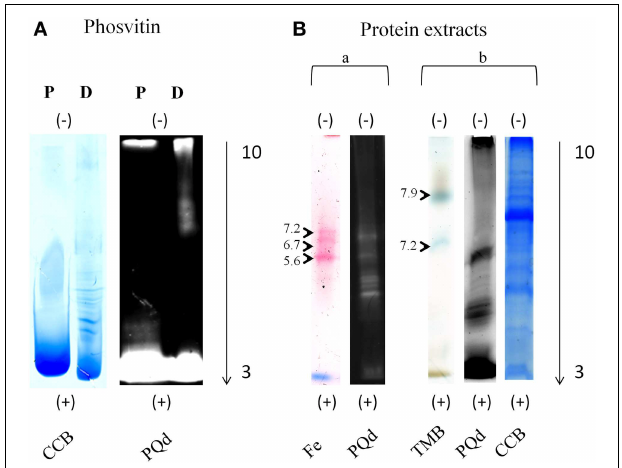
FIGURE 2 | IEF in-gel activity staining compatibility with Pro-Q Diamond ® staining. Separation of phosvitin and protein extracts (50 µ g) in non-reducing IEF pH 3–10. (A) Phosvitin separation followed by Pro-Q Diamond ® and CCB staining. P, phosphorylated; D, partially dephosphorylated. (B) Separation of protein extracts followed by in-gel activity, Pro-Q Diamond ® , and CCB staining. (a) Fe, Fe(III)-citrate/ferrozine/NADH (microsomes, pea roots); (b) TMB, TMB/H 2 O 2 (soluble fraction, corn leaves). Each in-gel activity staining procedure was followed by Pro-Q Diamond ® staining in the same gel. Type of staining is indicated at the bottom and pI of the bands indicated on the left of the gels. Cathode and anode are indicated as ( − ) and ( + ), respectively. Arrows show the direction of protein